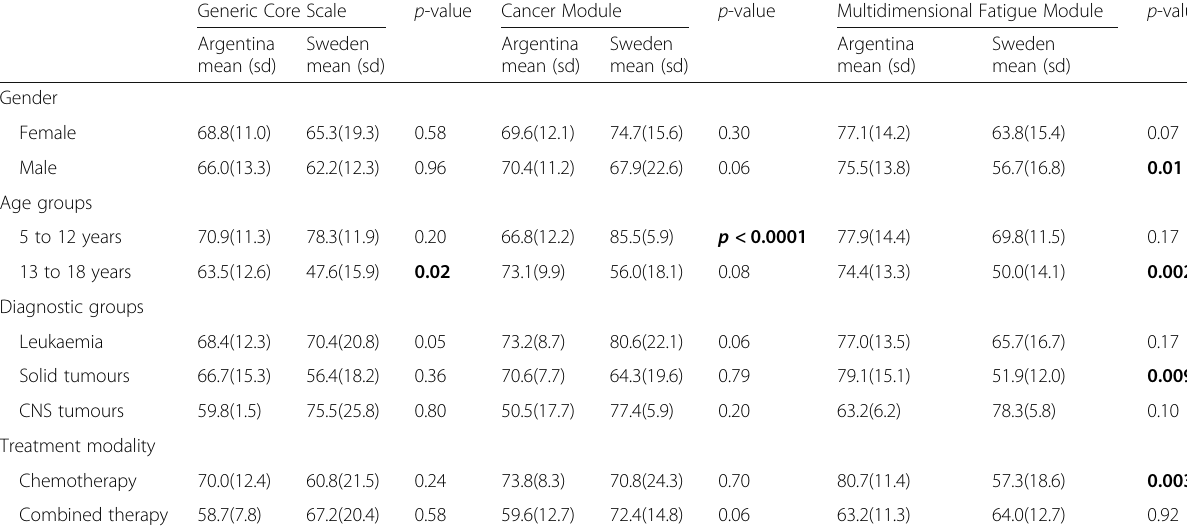
Table 2 PedsQL ™ , children ’ s self-reports: comparison between Argentina and Sweden